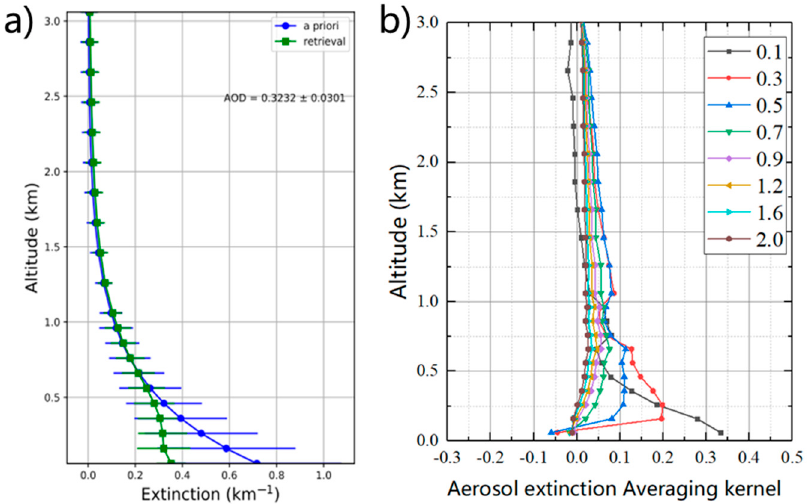
Figure A2. Example of aerosol extinction vertical profile retrieval (20 January 2020, 05:10:39 UTC time): ( a ) retrieved profile and a priori profile; ( b ) averaging kernel profiles.